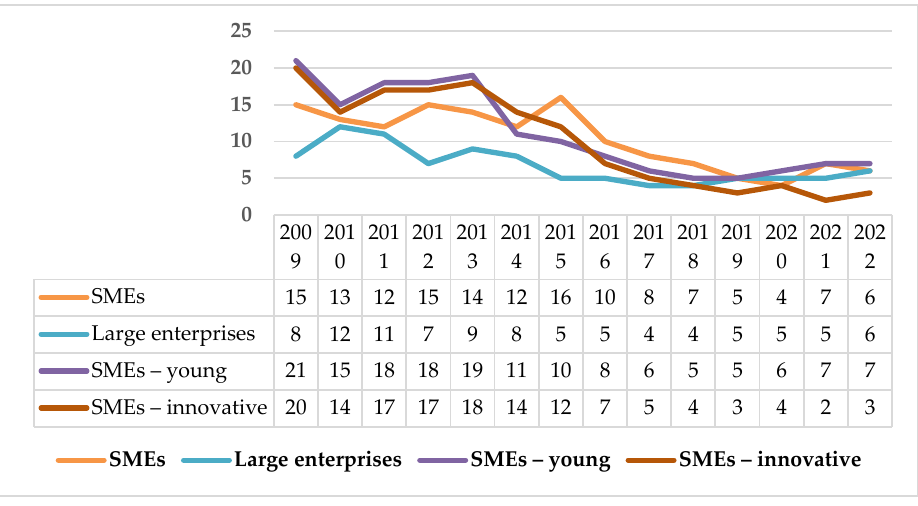
Figure 8. Financially limited firms according to age and size (weighted percentage of surveyed). Source: Adapted from Ref. [77].